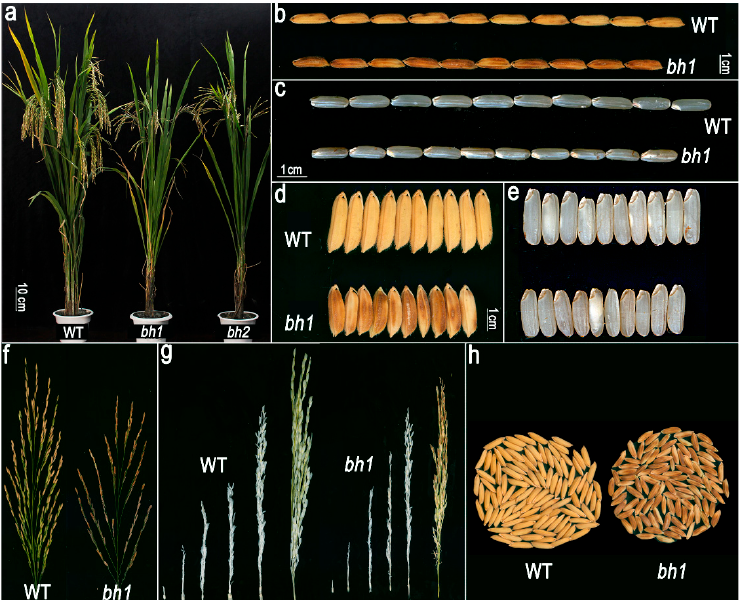
Figure 1. Phenotype observation and agronomic traits of brown hull1 (bh1). ( a ) Plant morphology of a Wild Type (WT) plant showing normal white-straw (left) while bh1 and bh2 plant (right) showed pigmentation on hull, ( b – e ) Mature grains and caryopsis of WT and bh1, ( f ) expanded view panicle of WT and bh1, ( g ) Different stages of a panicle of WT and bh1, ( h ) Morphology and appearance of bulk grains of WT and bh1.